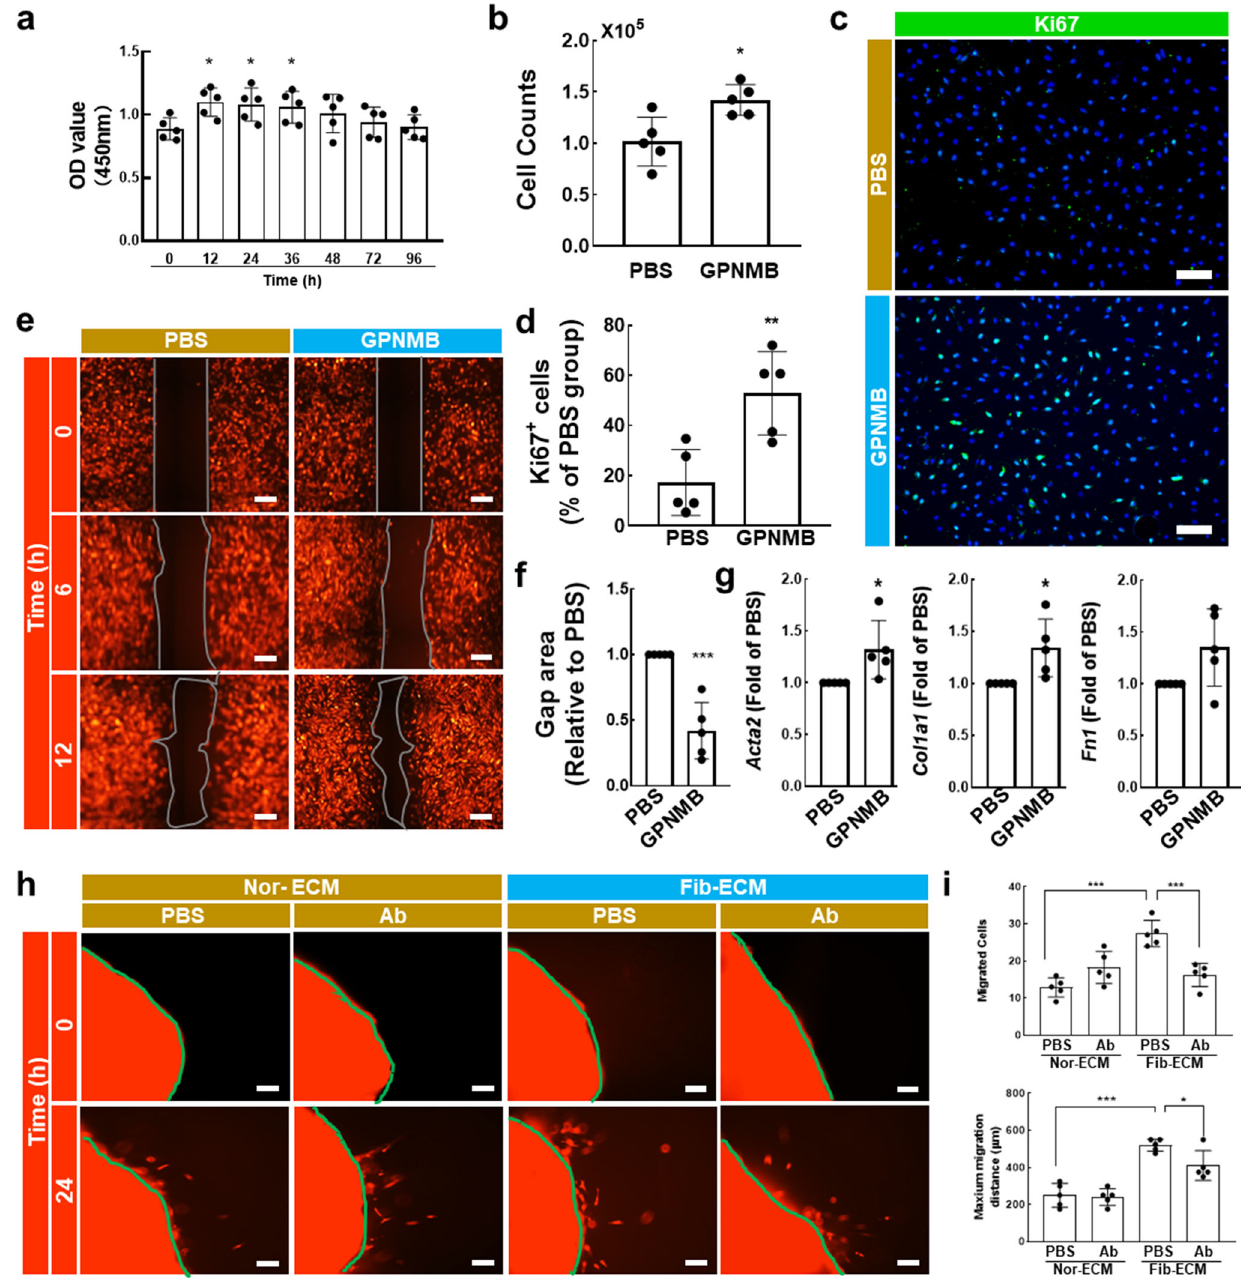
(0.1 μ g/mL) on normal fi broblast viability; n ≥ 5 independent experiments, *** p < 0.001, ** p < 0.01. b The effect of GPNMB (0.1 μ g/mL) on fi